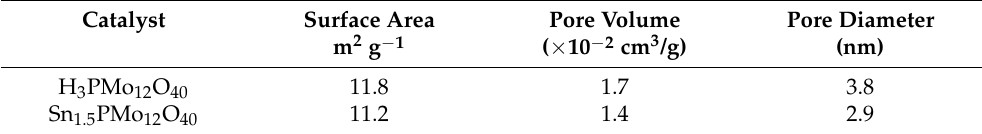
Table 2. Texture properties of H 3 PMo 12 O 40 and Sn 1.5 PMo 12 O 40 salt.